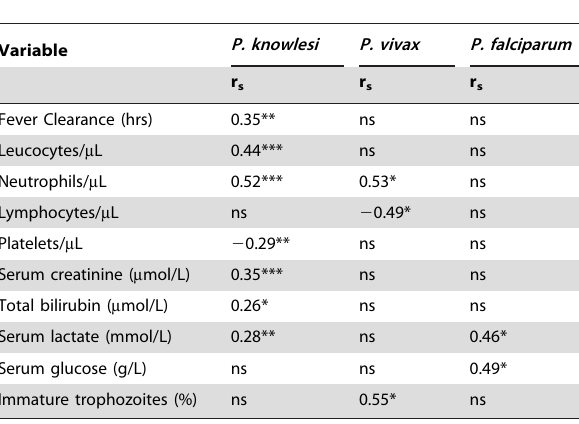
Table 1. Correlations of parasitaemia with clinical and laboratory